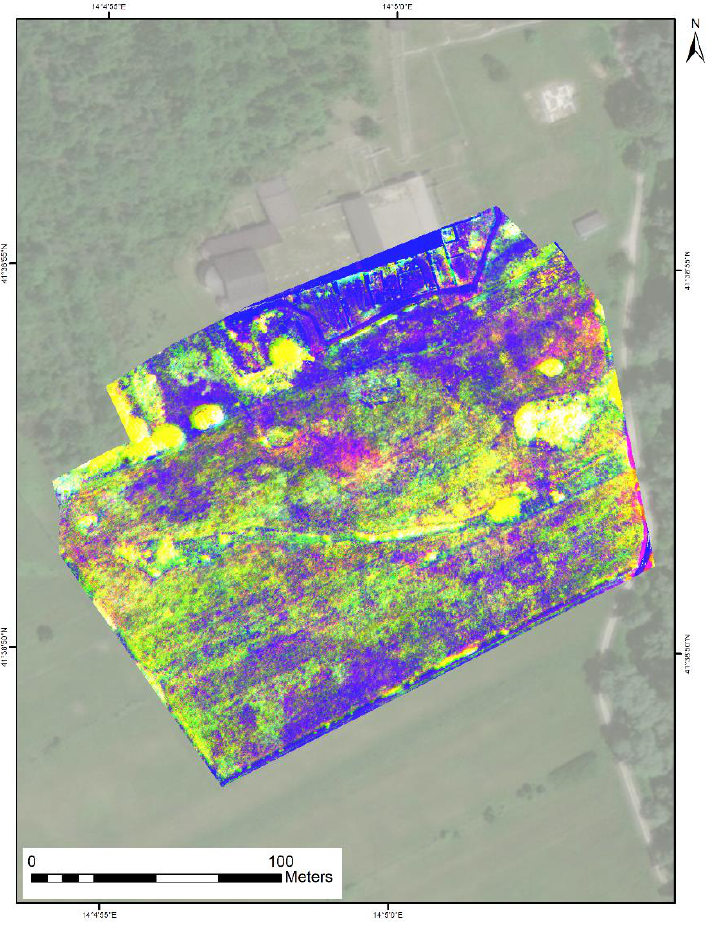
Figure 12. SPCAs obtained using correlation-matrix method. R: 4th PC; G: 23rd PC; B: 27th PC.